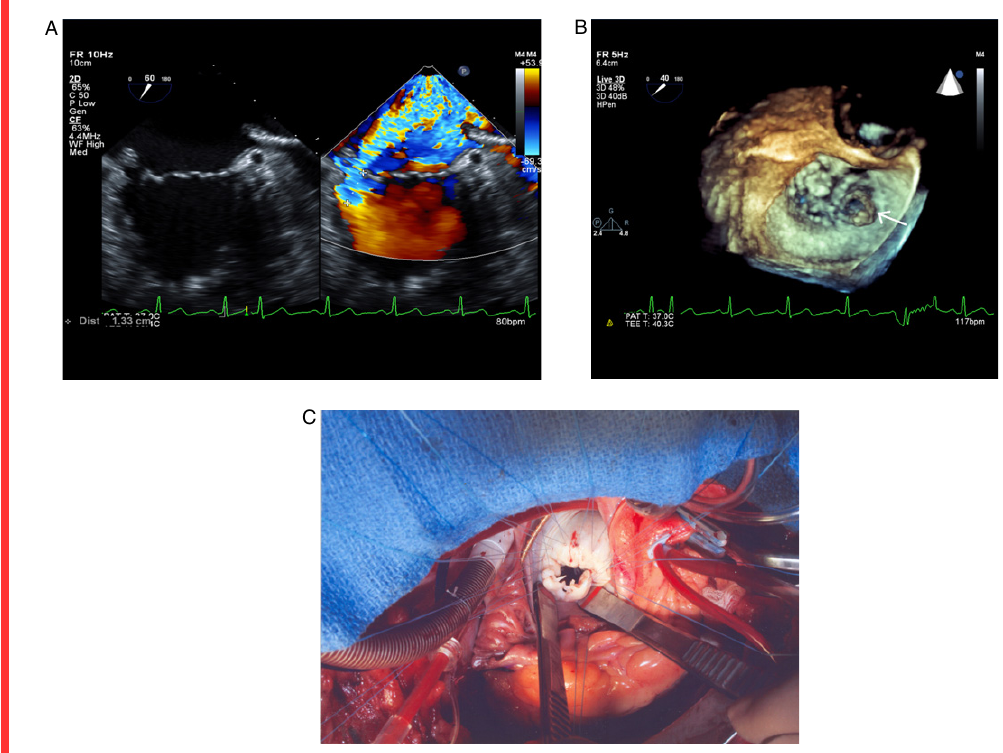
Figure. 2 TEE based 2D echocardiograph image ( 60 ◦ plane) from midesophagus (A) showing flow acceleration with color flow image through P3 (medial scallop). 3D echocardiograph image (B) demonstrates a discrete perforation on P3 (arrow). This corresponds to the surgical anatomy of the perforation secondary to prior infective